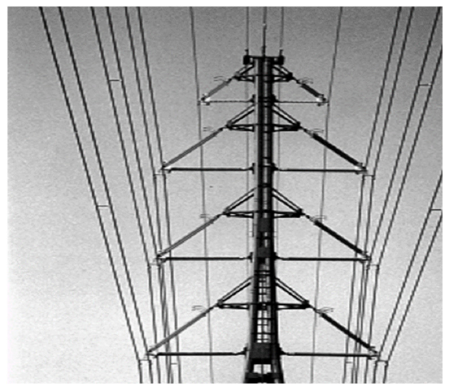
Figure 4. Comparison between compact lines and new lines for 400 kV [21].